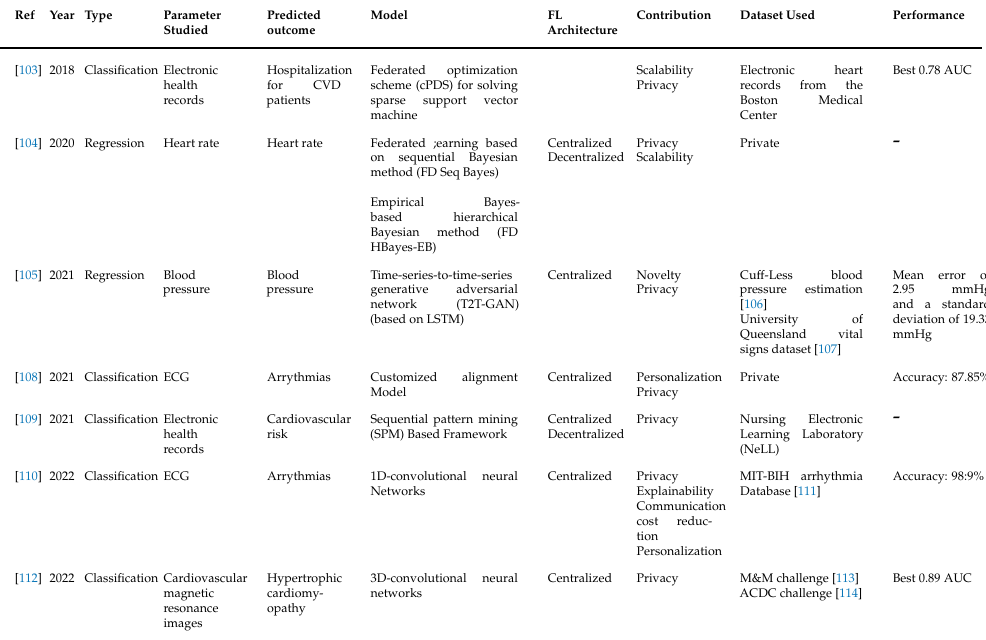
Table 4. Federated machine learning implementations in CVDs